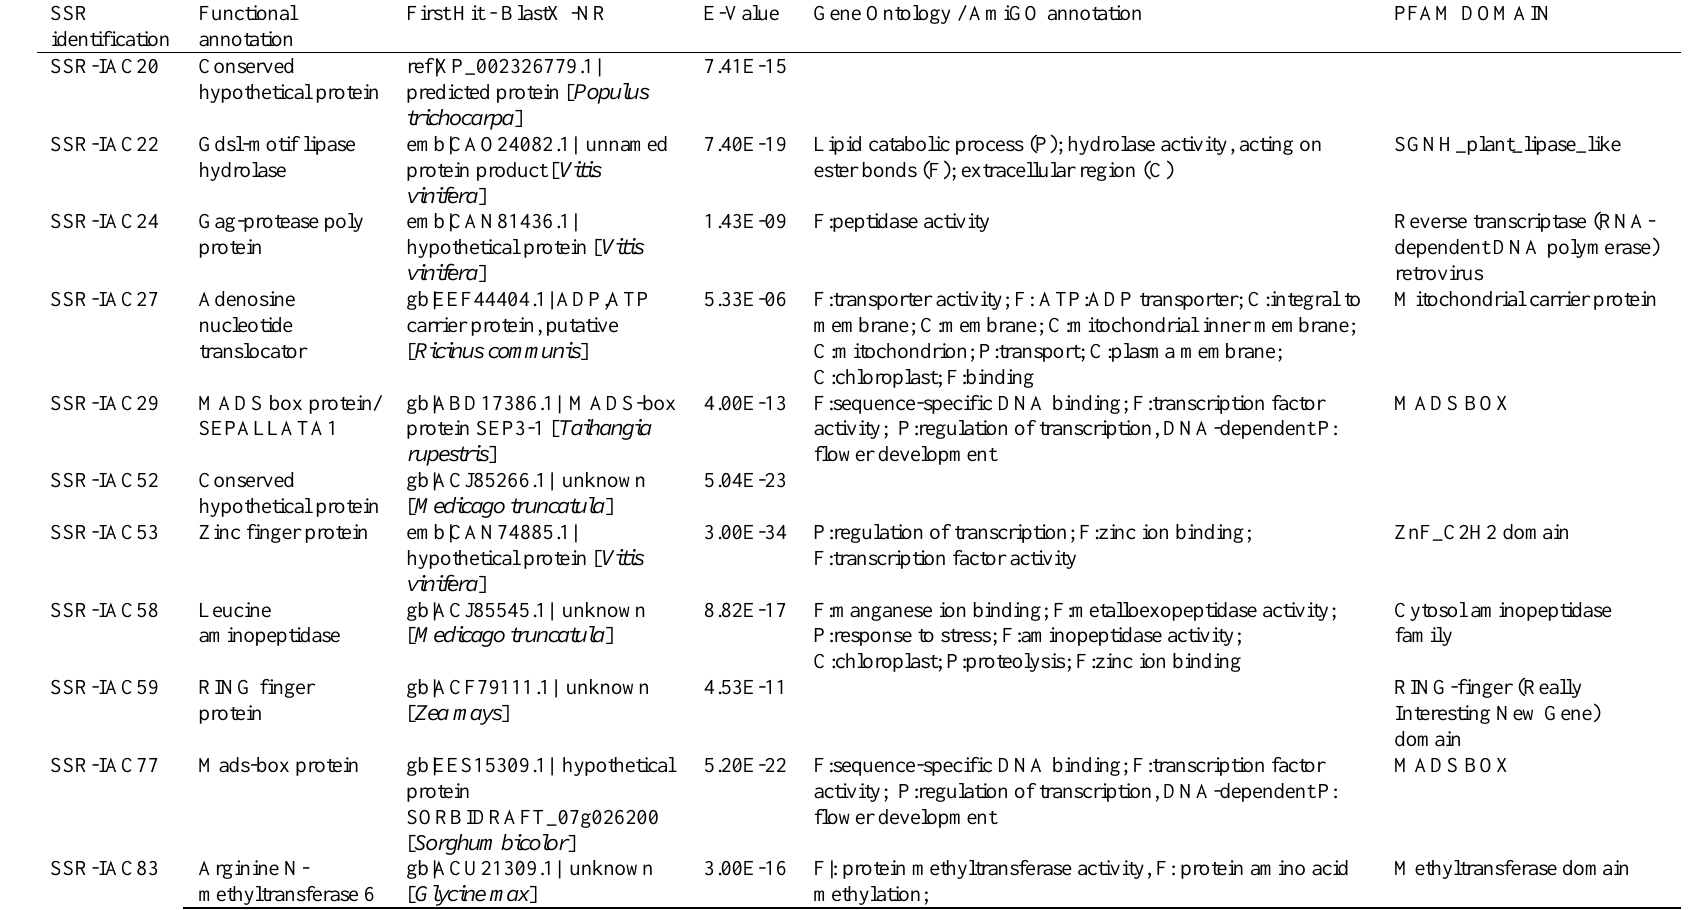
Table S1 – Functional annotations off SSRs containing similarity with proteins in